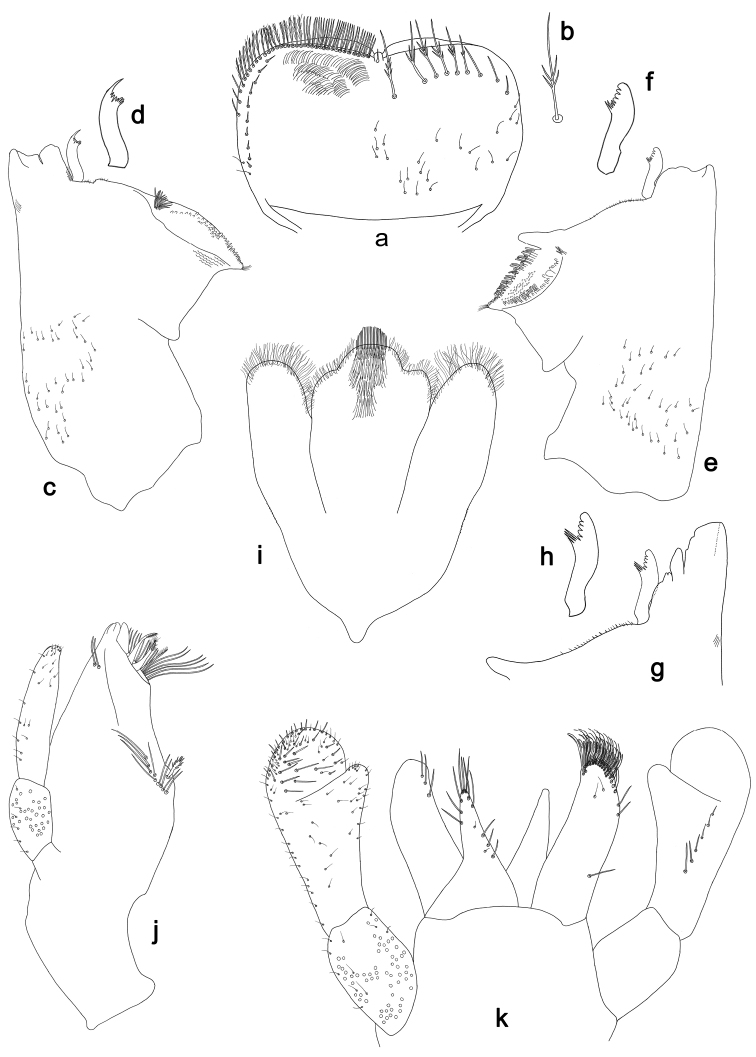
Labiobaetisdendrisetis sp. n., larva morphology: a Labrum b Labrum dorsal, submarginal seta c Right mandible, denticles outworn d Right prostheca e Left mandible, denticles outworn f Left prostheca g Left mandible, denticles unused h Left prostheca iHypopharynxj Maxilla k Labium.